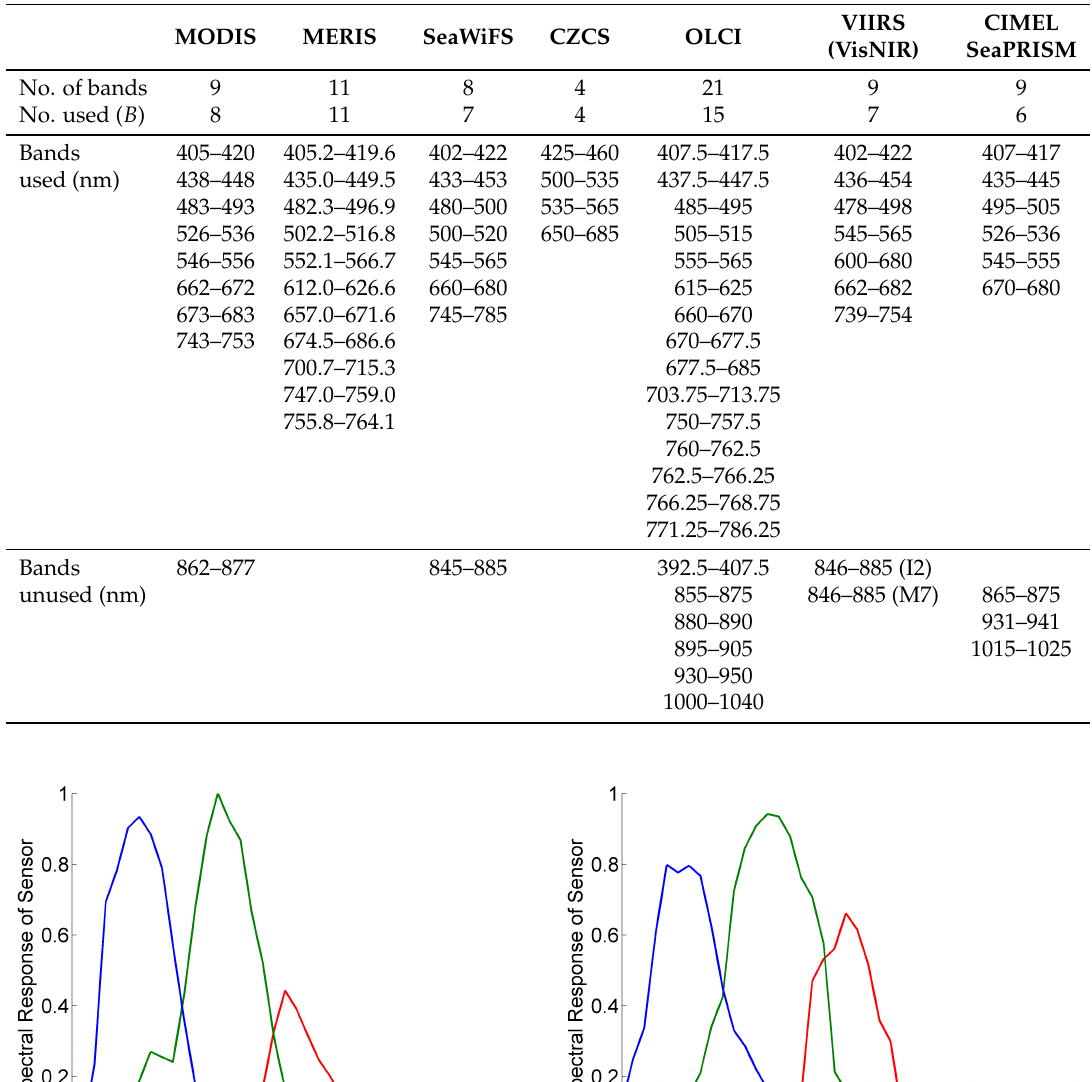
Table 1. Information of the bands of satellite sensors.